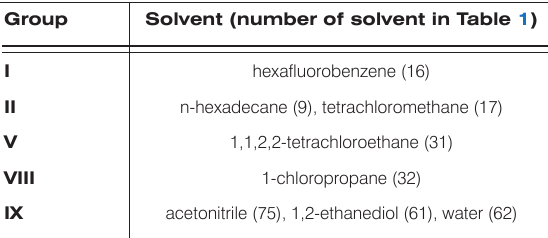
Table 4. Classification of solvents from the second testing set. Group